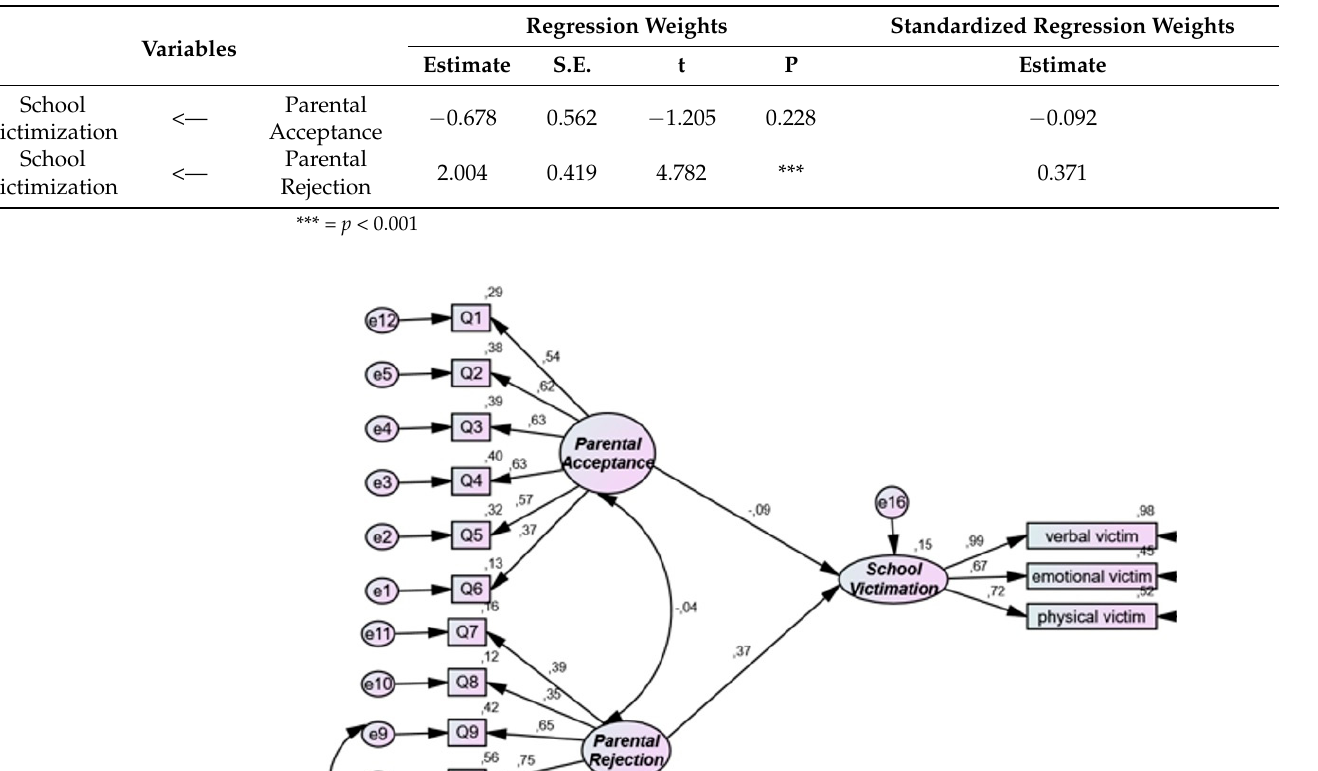
Table 4. Estimates of the effect of parental acceptance and rejection of adolescents on school victim- ization.